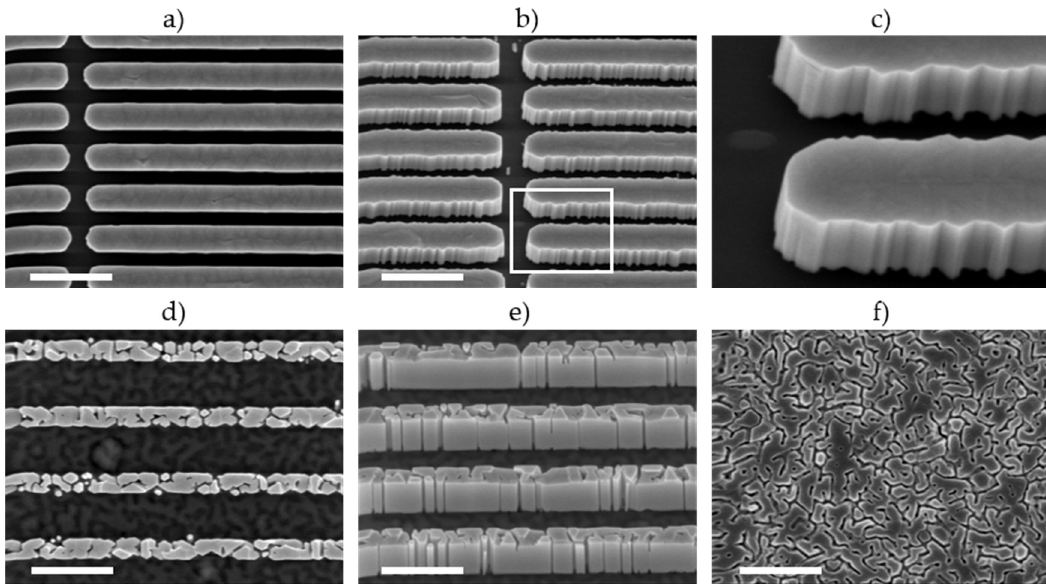
Figure 3. FESEM images of SAG lines: ( a ), ( b ), and ( c ) on a commercial N-polar GaN substrate (N-GaN), 300 nm wide; ( d ) and ( e ), on a PAMBE grown N-polar GaN + SL/AlN/Si(111) substrate (N–AlGaSl-2), 250 nm wide. Complete filling of the lines is achieved on the N-polar GaN substrate, but not on the PAMBE substrate. Image ( f ) is of a bare PAMBE grown N-polar GaN + SL/AlN/Si(111), taken prior to processing for SAG. The scale of all the images is the same (white lines are 1 µm long), except ( c ) which is a magnified view of the area outlined in ( b ) and shows m-plane faceting of sidewalls patterned along the a-plane.